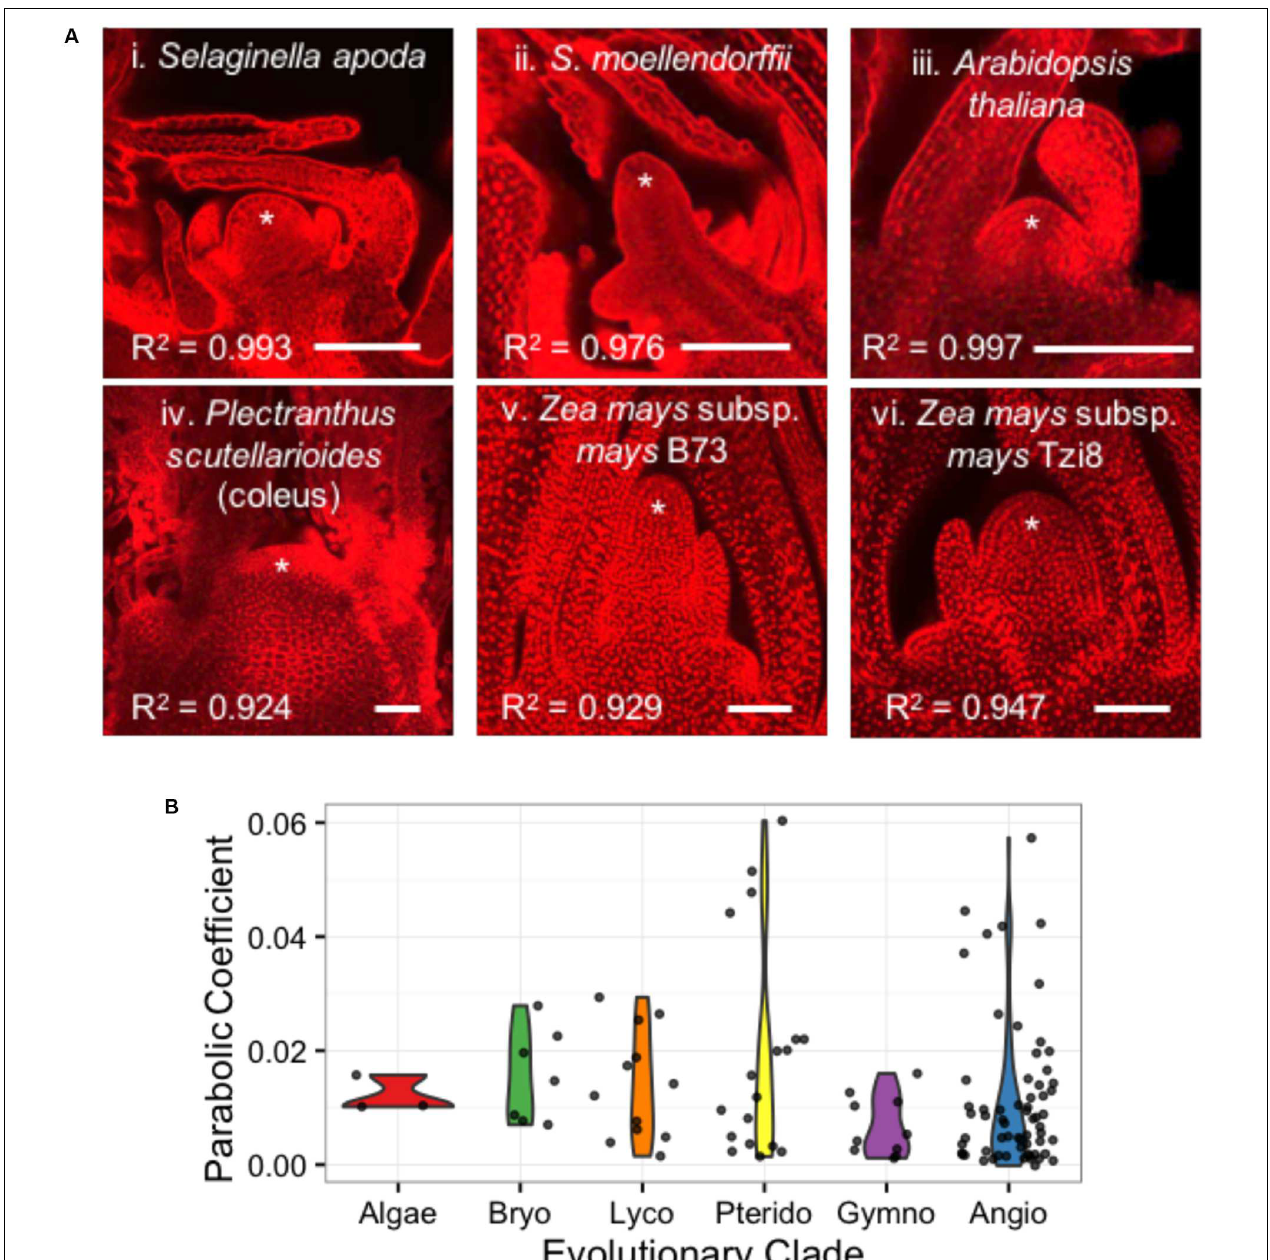
FIGURE 6 | Diverse SAMs are well-estimated by parabolic shape models. (A) Median optical sections of the vegetative apex from example lycophytes with a shoot meristem dominated by an inverted pyramidal cell (i, ii) and angiosperms exhibiting a ‘tunica-corpus’ shoot meristem anatomy with at least one clonal ‘tunica’ layer (iii–vi). ∗ indicates SAM and flanking leaf primorida. R 2 , goodness-of-fit of parabolic model. Bar, 50 um. (B) SAMs from broadly diverse evolutionary lineages exhibit a range of parabolic